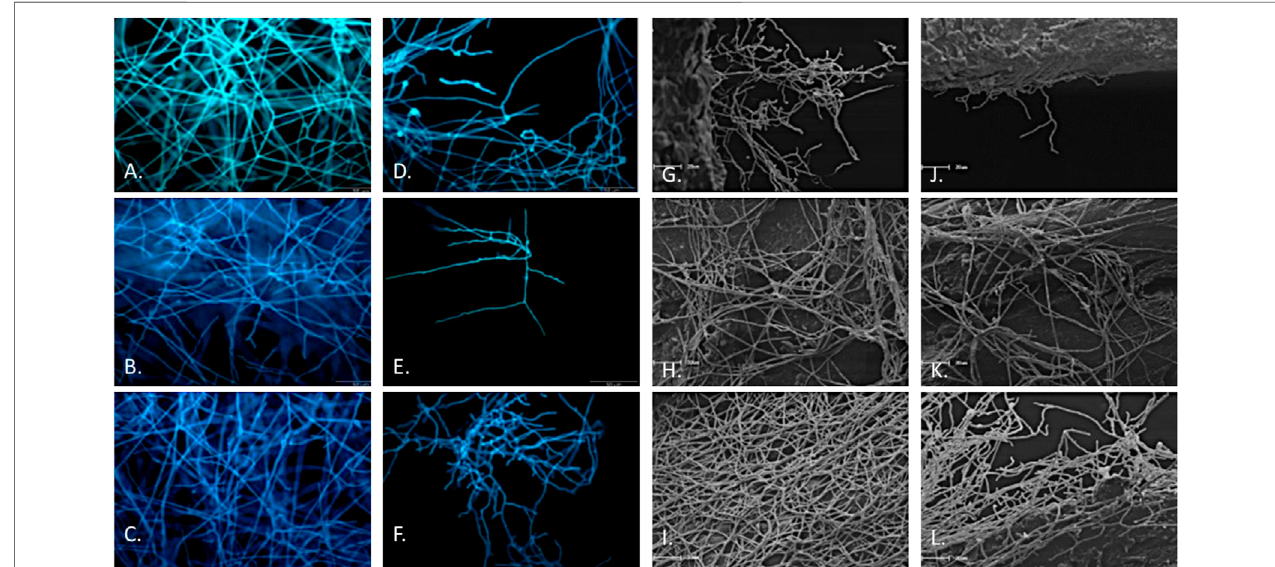
FIGURE 6 | Fluorescence microscopy. (A – C) Control cells of T. rubrum, T. mentagrophytes and M. gypseum , respectively. (D – F) T. rubrum , T. mentagrophytes and M. gypseum treated with 31.2, 62.5, and 31.2 μ g/ml of T. riparia extract, respectively. Scanning Electron Microscopy, (G – I) Control cells of T. rubrum, T. mentagrophytes and M.gypseum , respectively. (J – L) T.rubrum , T. mentagrophytes and M. gypseum treatedwith one-foldsub-MICconcentrationsofT.riparia extract (adapted from Endo et al., 2015 1 ).